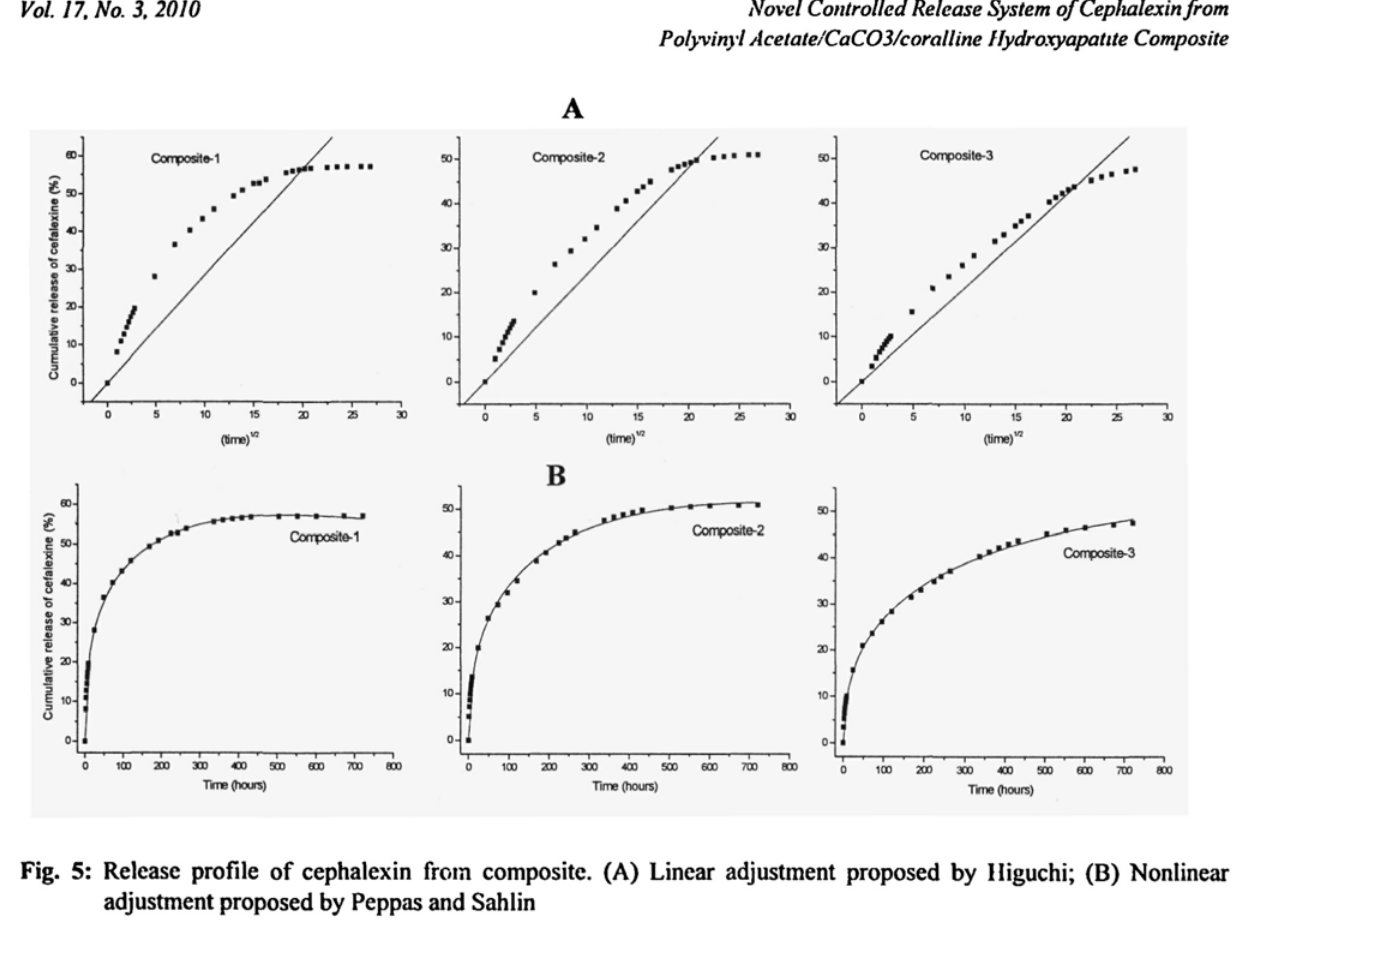
Fig. 5: Release profile of cephalexin from composite. (A) Linear adjustment proposed by Higuchi; (B) Nonlinear adjustment proposed by Peppas and